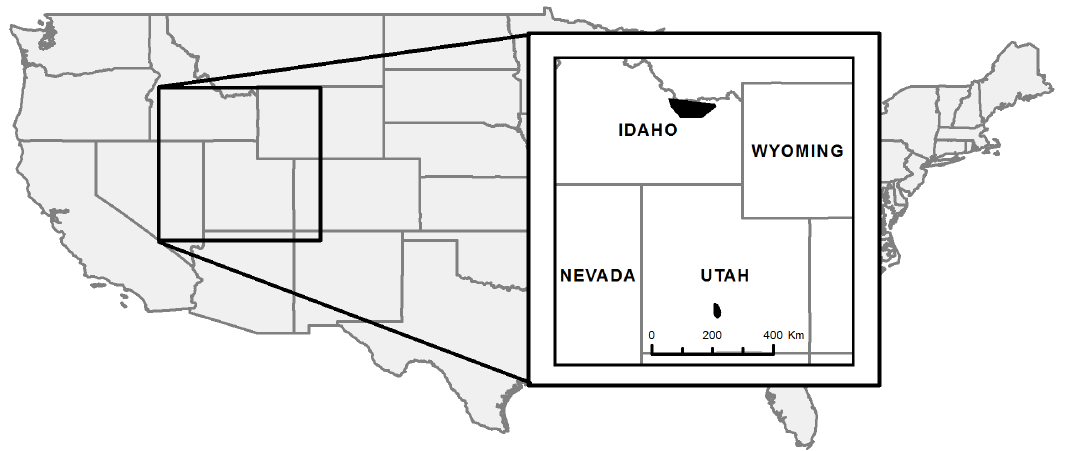
Figure 1. Map of study areas in Idaho and Utah.